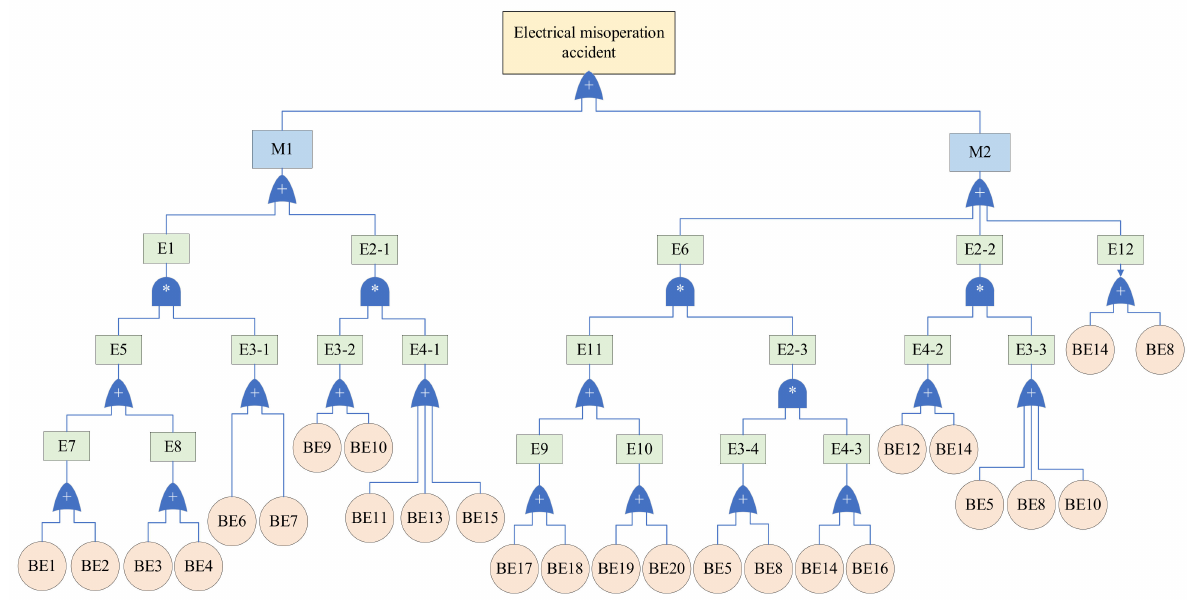
Figure 5. FT structure of